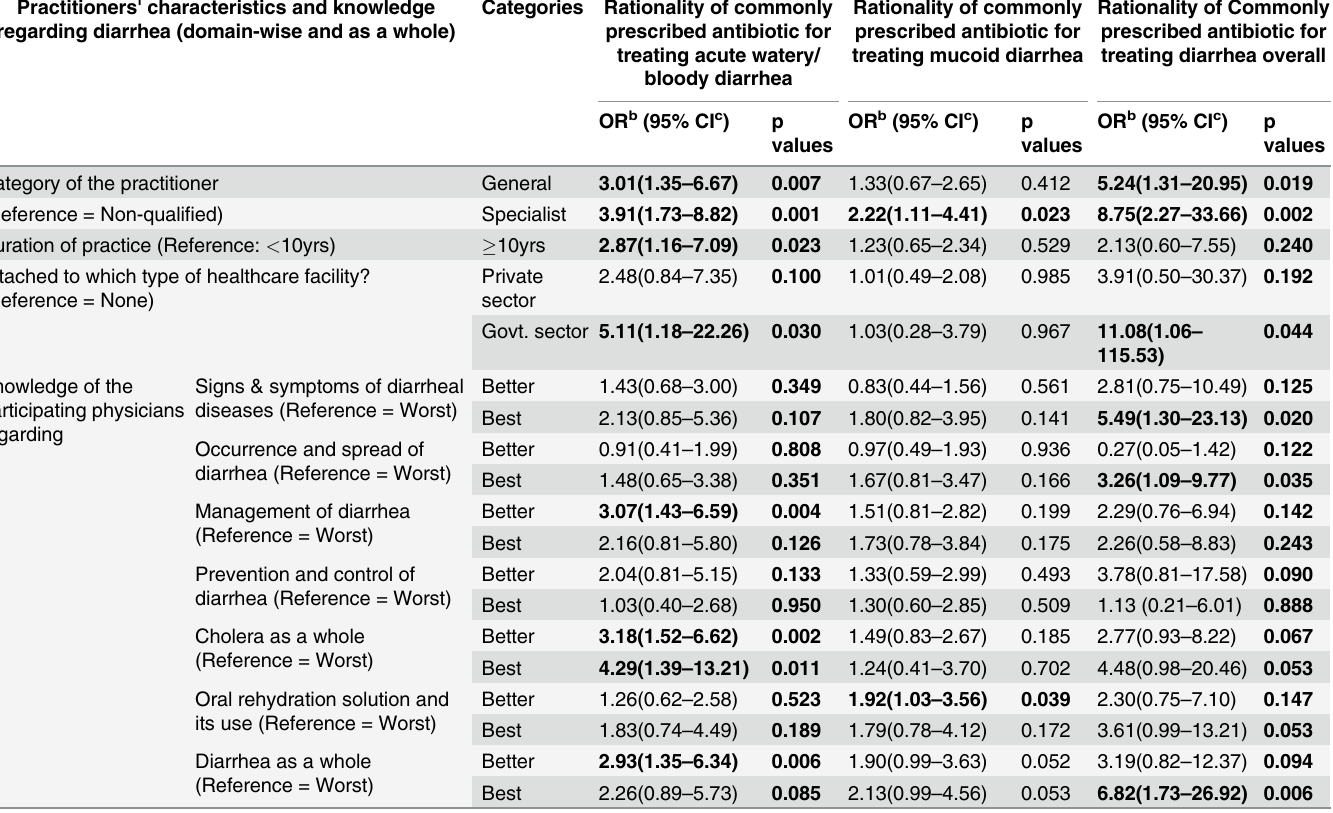
Table 2. Association of physician ’ s characteristics and knowledge regarding diarrhea with rationality of antibiotic use for diarrheal management (N a = 264). Practitioners' characteristics and knowledge regarding diarrhea (domain-wise and as a